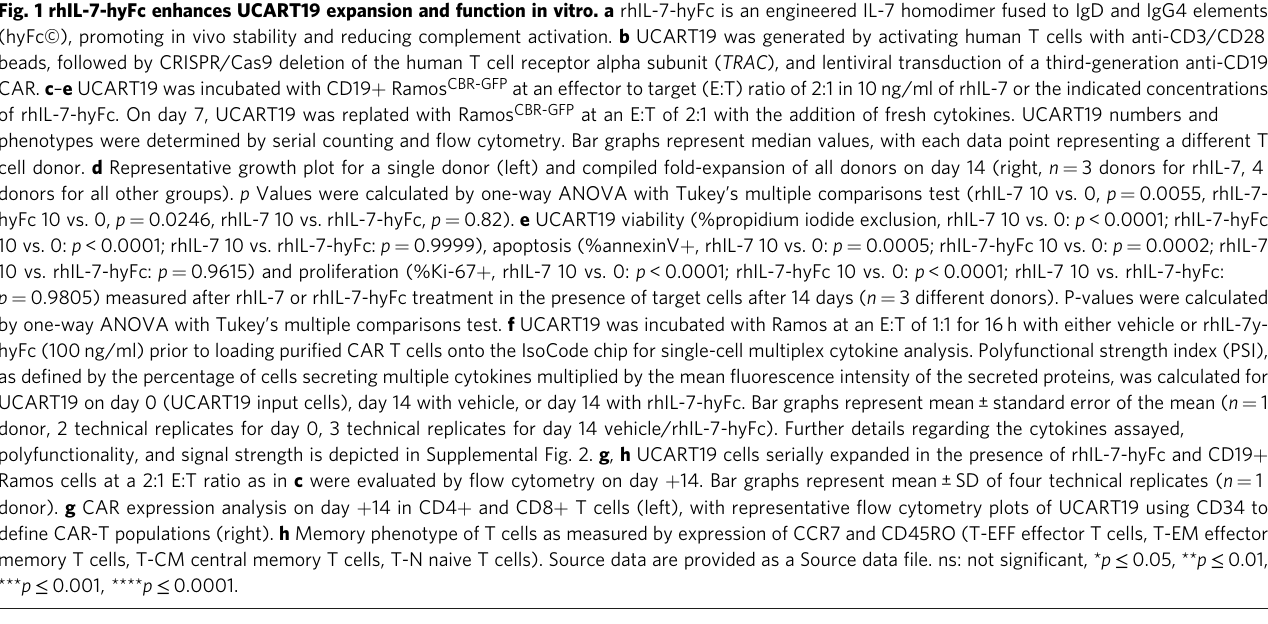
Fig. 1 rhIL-7-hyFc enhances UCART19 expansion and function in vitro. a rhIL-7-hyFc is an engineered IL-7 homodimer fused to IgD and IgG4 elements (hyFc©), promoting in vivo stability and reducing complement activation. b UCART19 was generated by activating human T cells with anti-CD3/CD28 beads, followed by CRISPR/Cas9 deletion of the human T cell receptor alpha subunit ( TRAC ), and lentiviral transduction of a third-generation anti-CD19 CAR. c – e UCART19 was incubated with CD19 + Ramos CBR-GFP at an effector to target (E:T) ratio of 2:1 in 10 ng/ml of rhIL-7 or the indicated concentrations of rhIL-7-hyFc. On day 7, UCART19 was replated with Ramos CBR-GFP at an E:T of 2:1 with the addition of fresh cytokines. UCART19 numbers and phenotypes were determined by serial counting and fl ow cytometry. Bar graphs represent median values, with each data point representing a different T cell donor. d Representative growth plot for a single donor (left) and compiled fold-expansion of all donors on day 14 (right, n = 3 donors for rhIL-7,